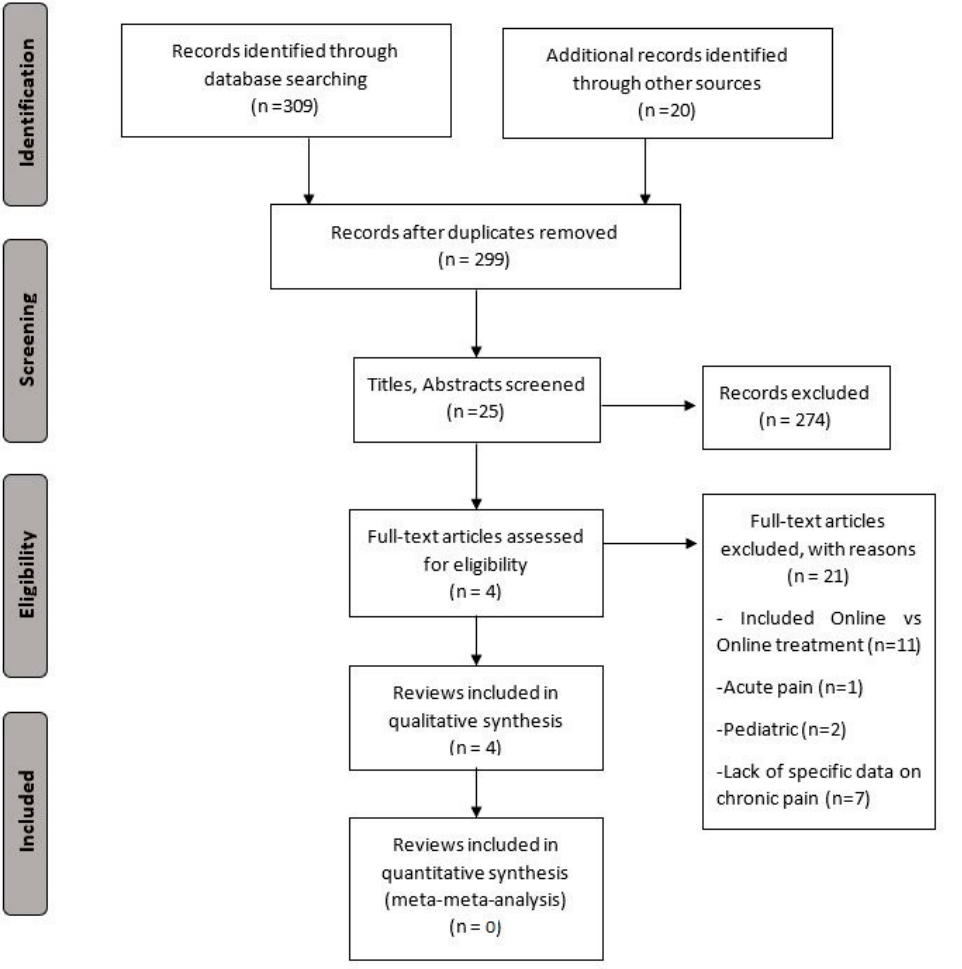
Figure 1. PRISMA flowchart of study selection.